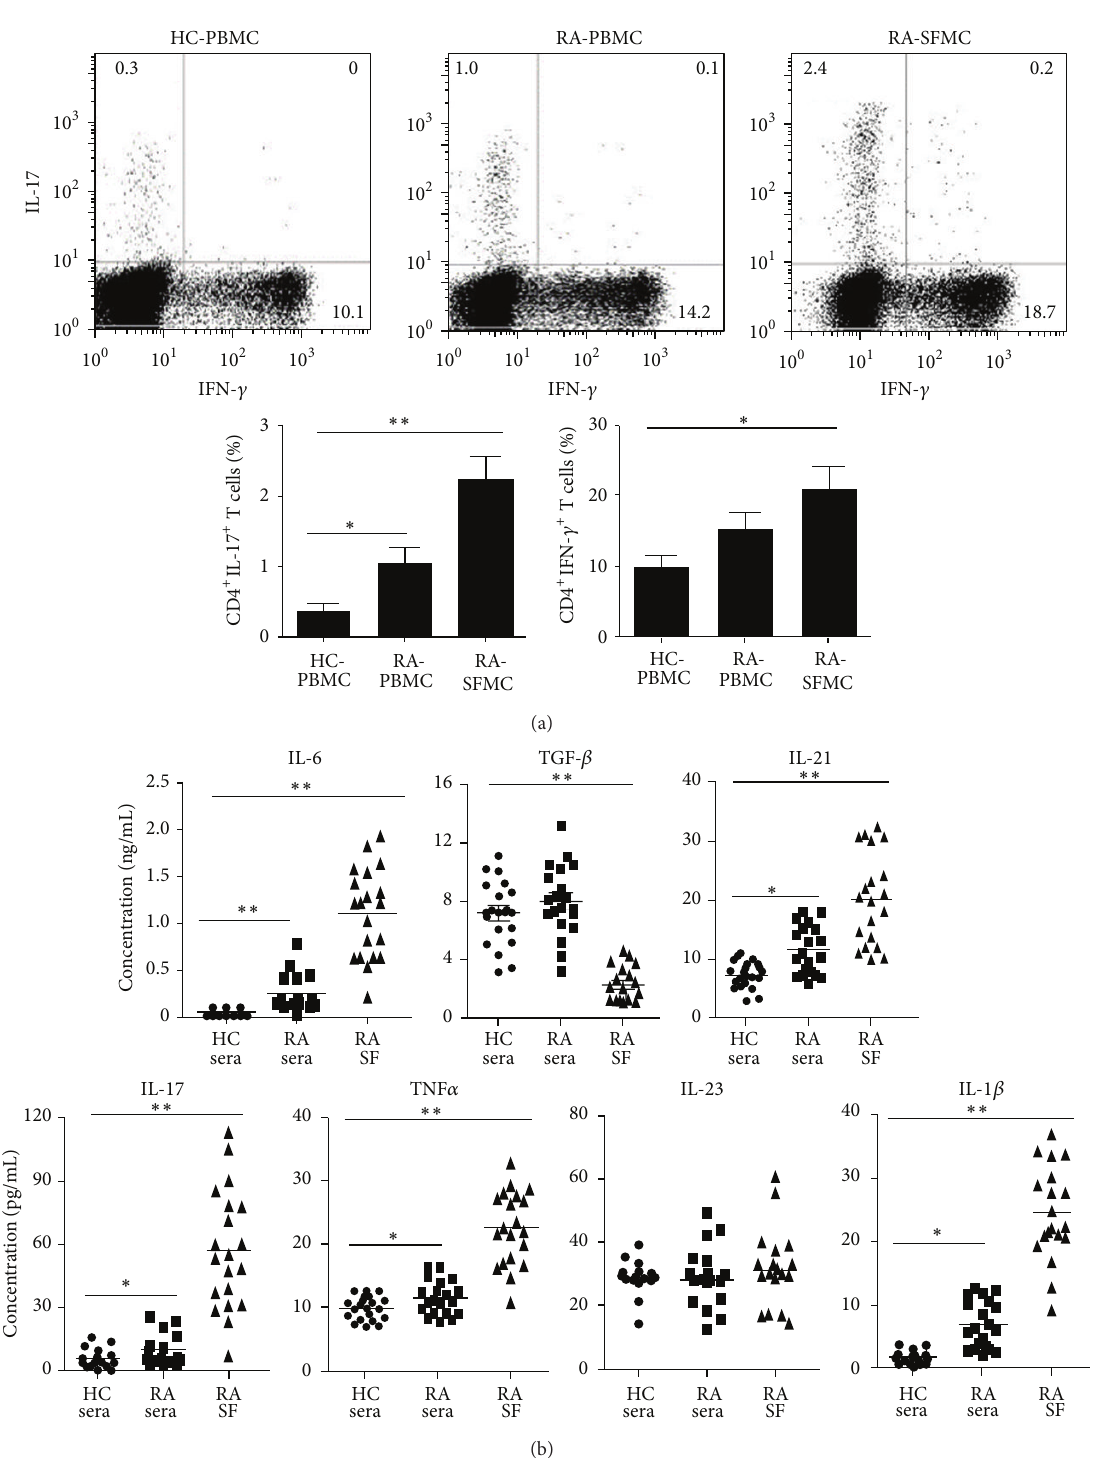
Figure 1: Increased percentage of Th17 and Th1 cells in RA synovial fluid. (a) Percentage of Th1 and Th17 cells was analyzed in CD4 subset from PBMC and SFMC of RA patients (RA-PBMC, RA-SFMC) or PBMC of healthy individuals (HC-PBMC) by intracellular staining of IFN- 𝛾 and IL-17, respectively, using flow cytometry. Data are representative of 20 samples (up row). Bars show the mean ± SEM (down row). (b) Cytokine levels were measured by ELISA in synovial fluid (SF) and serum samples from 20 RA patients. A panel of 20 serum specimens from healthy individuals was included as controls (HC). Lines represent mean concentration values. In all cases, asterisks indicate statistically significant differences between the groups ( ∗ 𝑃 < 0.05 , ∗∗ 𝑃 < 0.01